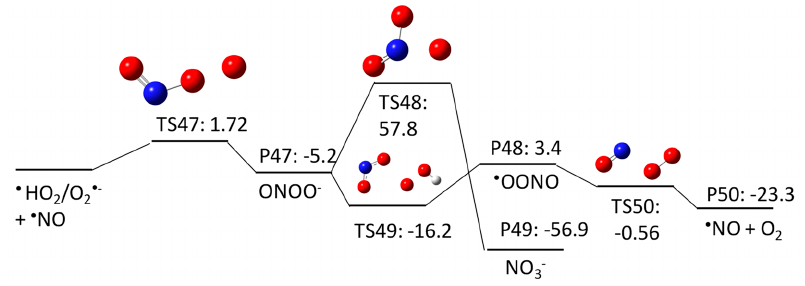
Figure 14. Free energy profile for pathway 4–3 of the HO • -induced reaction pathways for NDMA photolysis.